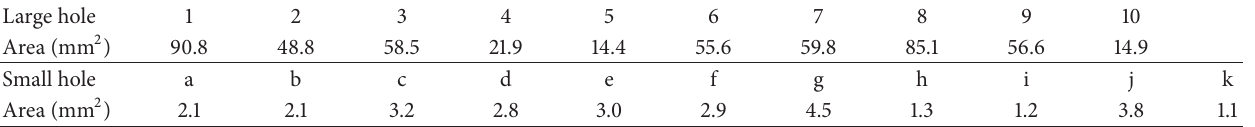
Figure 2: Finite element model of the cross-sectional area of lotus root. Table 1: Area of holes in the cross-sectional area of the lotus root.